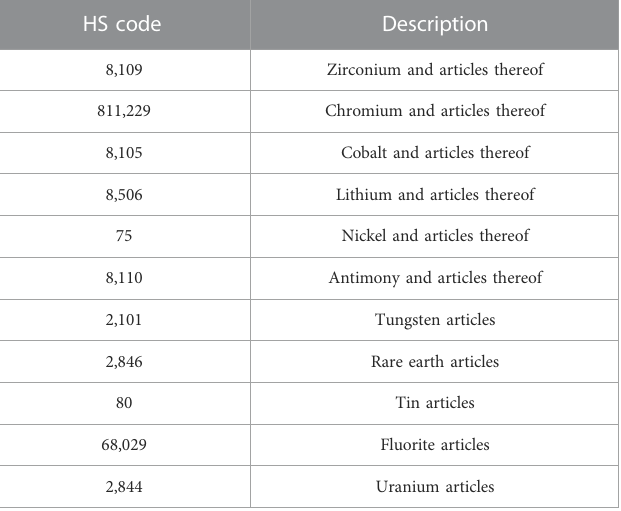
TABLE 2 HS code for strategic and critical mineral